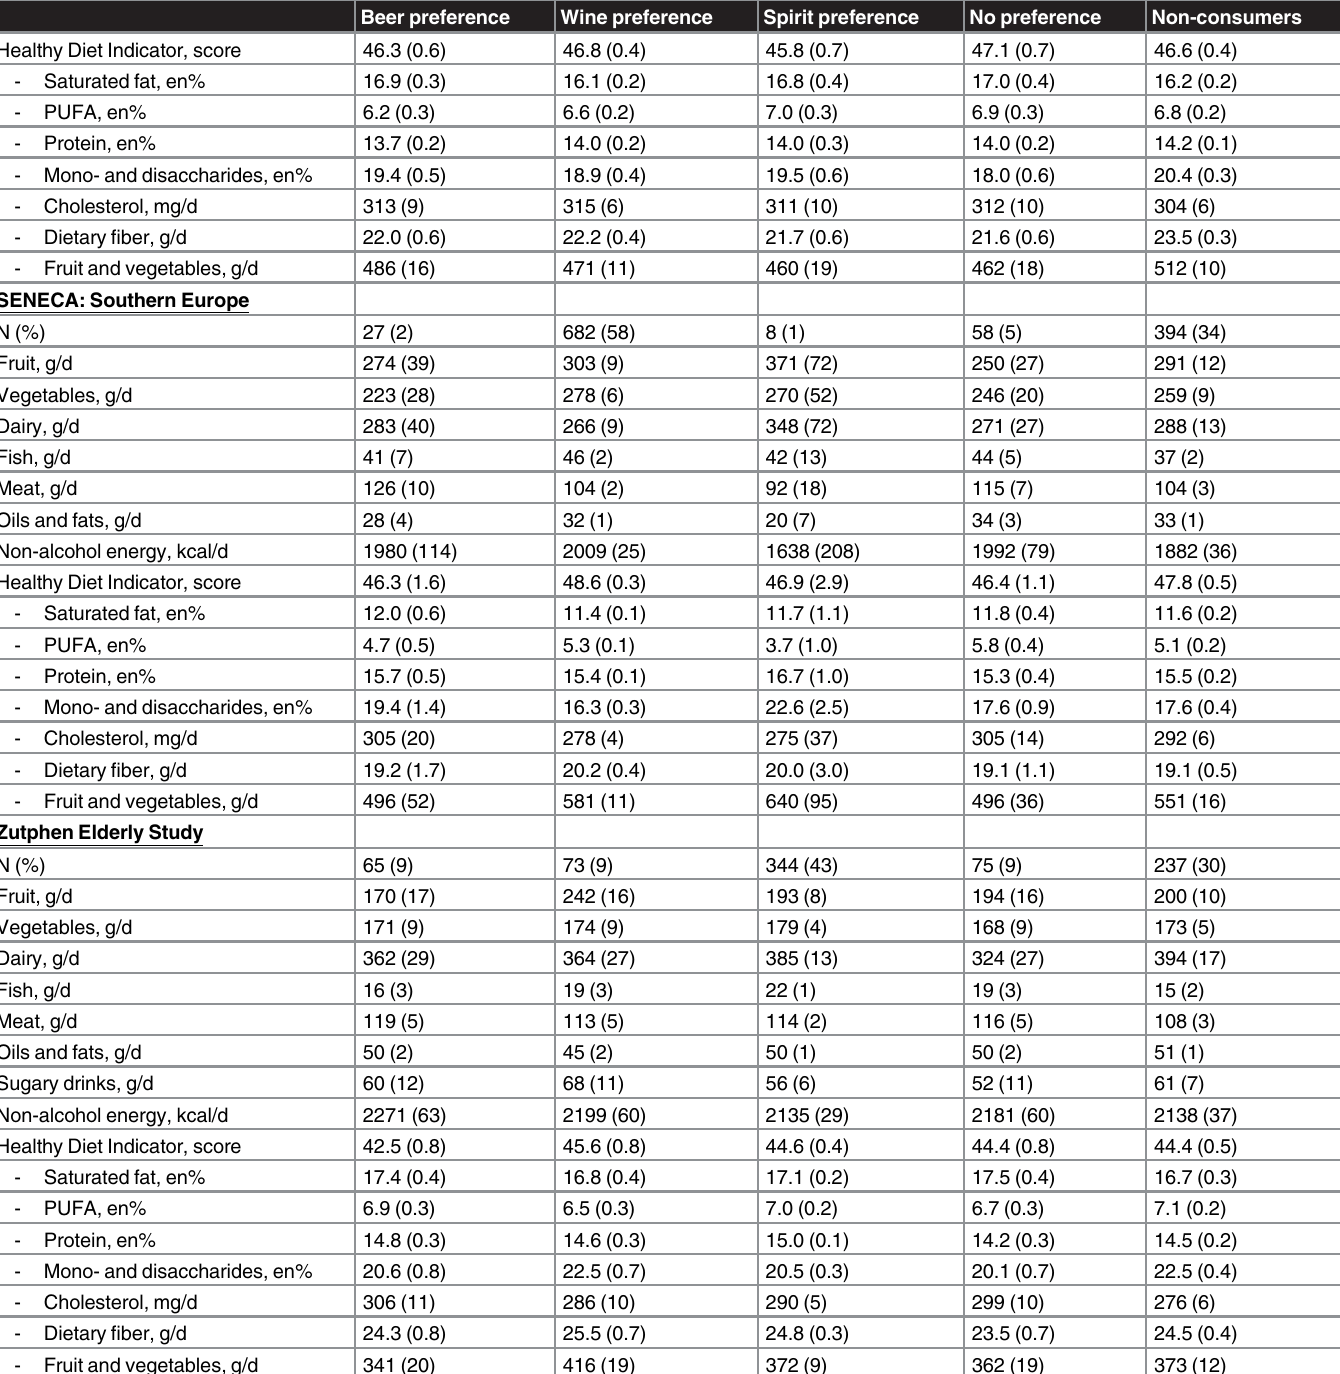
Abbreviations: poly-unsaturated fatty acids (PUFA)